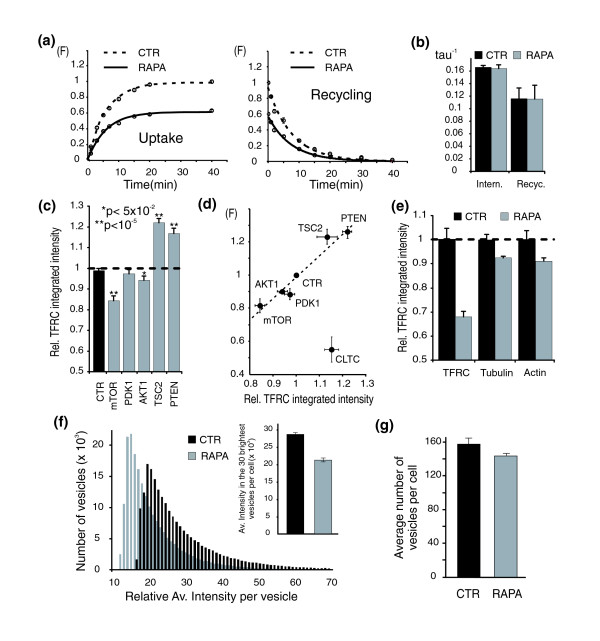
mTOR controls transferrin uptake by regulation of the number of transferrin receptors per vesicle and not endocytosis or recycling rates. (a) Effect of rapamycin on the time-course of fluorescent transferrin endocytosis (left) and recycling (right). Means ± standard error of the mean (SEM; n = 4 replicates). (b) Lack of effect of rapamycin on the rate constants for endocytosis and recycling. The rate constants, tau-1, were calculated from a single exponential fit of the time-course data. (c) Effect of the PtdIns(3,4,5)P3-mTOR-targeting d-siRNAs on the number of transferrin receptors (TFRC) per cell (measured by immunofluorescence on permeabilized cells). Means ± SEM (n = 4). (d) Correlation between transferrin uptake (F, vertical axis) and transferrin receptor numbers (immunofluorescence measurements on permeabilized cells, horizontal axis) in HeLa cells in which PtdIns(3,4,5)P3-mTOR regulators were silenced. Means ± SEM (n = 4). (e) Selective effect of rapamycin on transferrin receptor staining (TFRC) compared to tubulin and actin staining. Means ± SEM (n = 6 replicates). (f) Rapamycin preferentially reduces the number of transferrin molecules per vesicles. Histogram of the relative transferrin fluorescence intensity per vesicle for control (CTR) and rapamycin (RAPA)-treated cells. Means ± SEM (n = 6 replicates). Inset shows the average intensity measured for the 30 brightest vesicles per cell. (g) Rapamycin has only a minor effect on the number of endocytic vesicles. Bar diagram shows means ± SEM (n = 6 replicates).